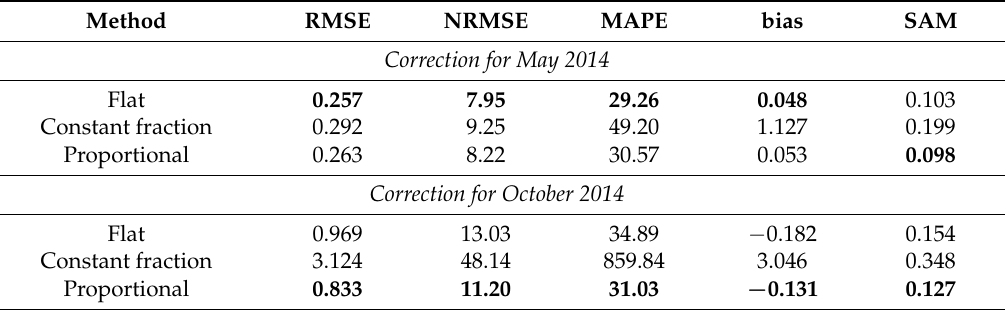
Table 2. Assessment of the scattering error correction methods for the datasets collected in May and